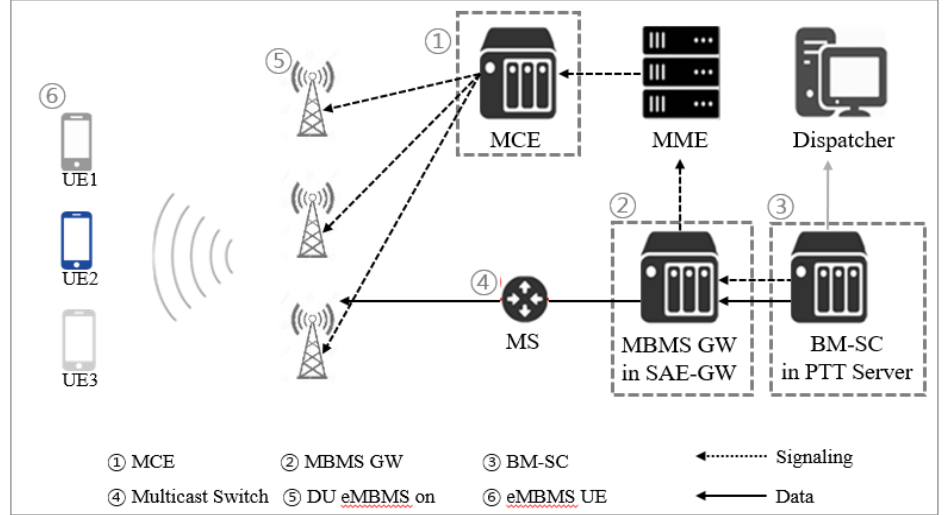
Figure 7. Configuration diagram of eMBMS-based service network.